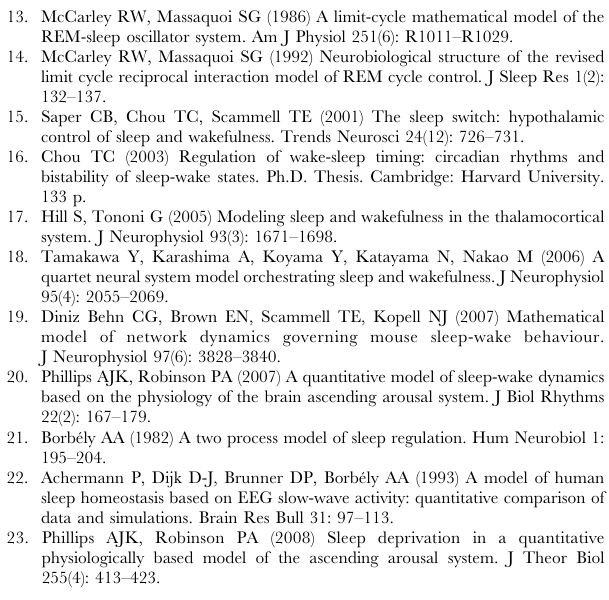
Figure S1 Brainstem firing rate and EEG activity. (a) Firing rate in a midbrain reticular neuron of the cat during repeated EEG desynchronisation-synchronisation transitions. The appearance of each spindle is paralleled by a marked decrease in firing rate. (b) Results from 12 such transitions confirming the relative instantaneity of the individual neuron time to transition from fast to spindle mode which on average is , 1.5 seconds as compared to several minutes for the NREM episode duration